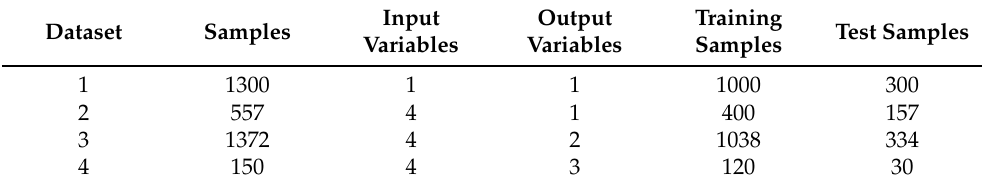
Table 6. Information about the datasets.